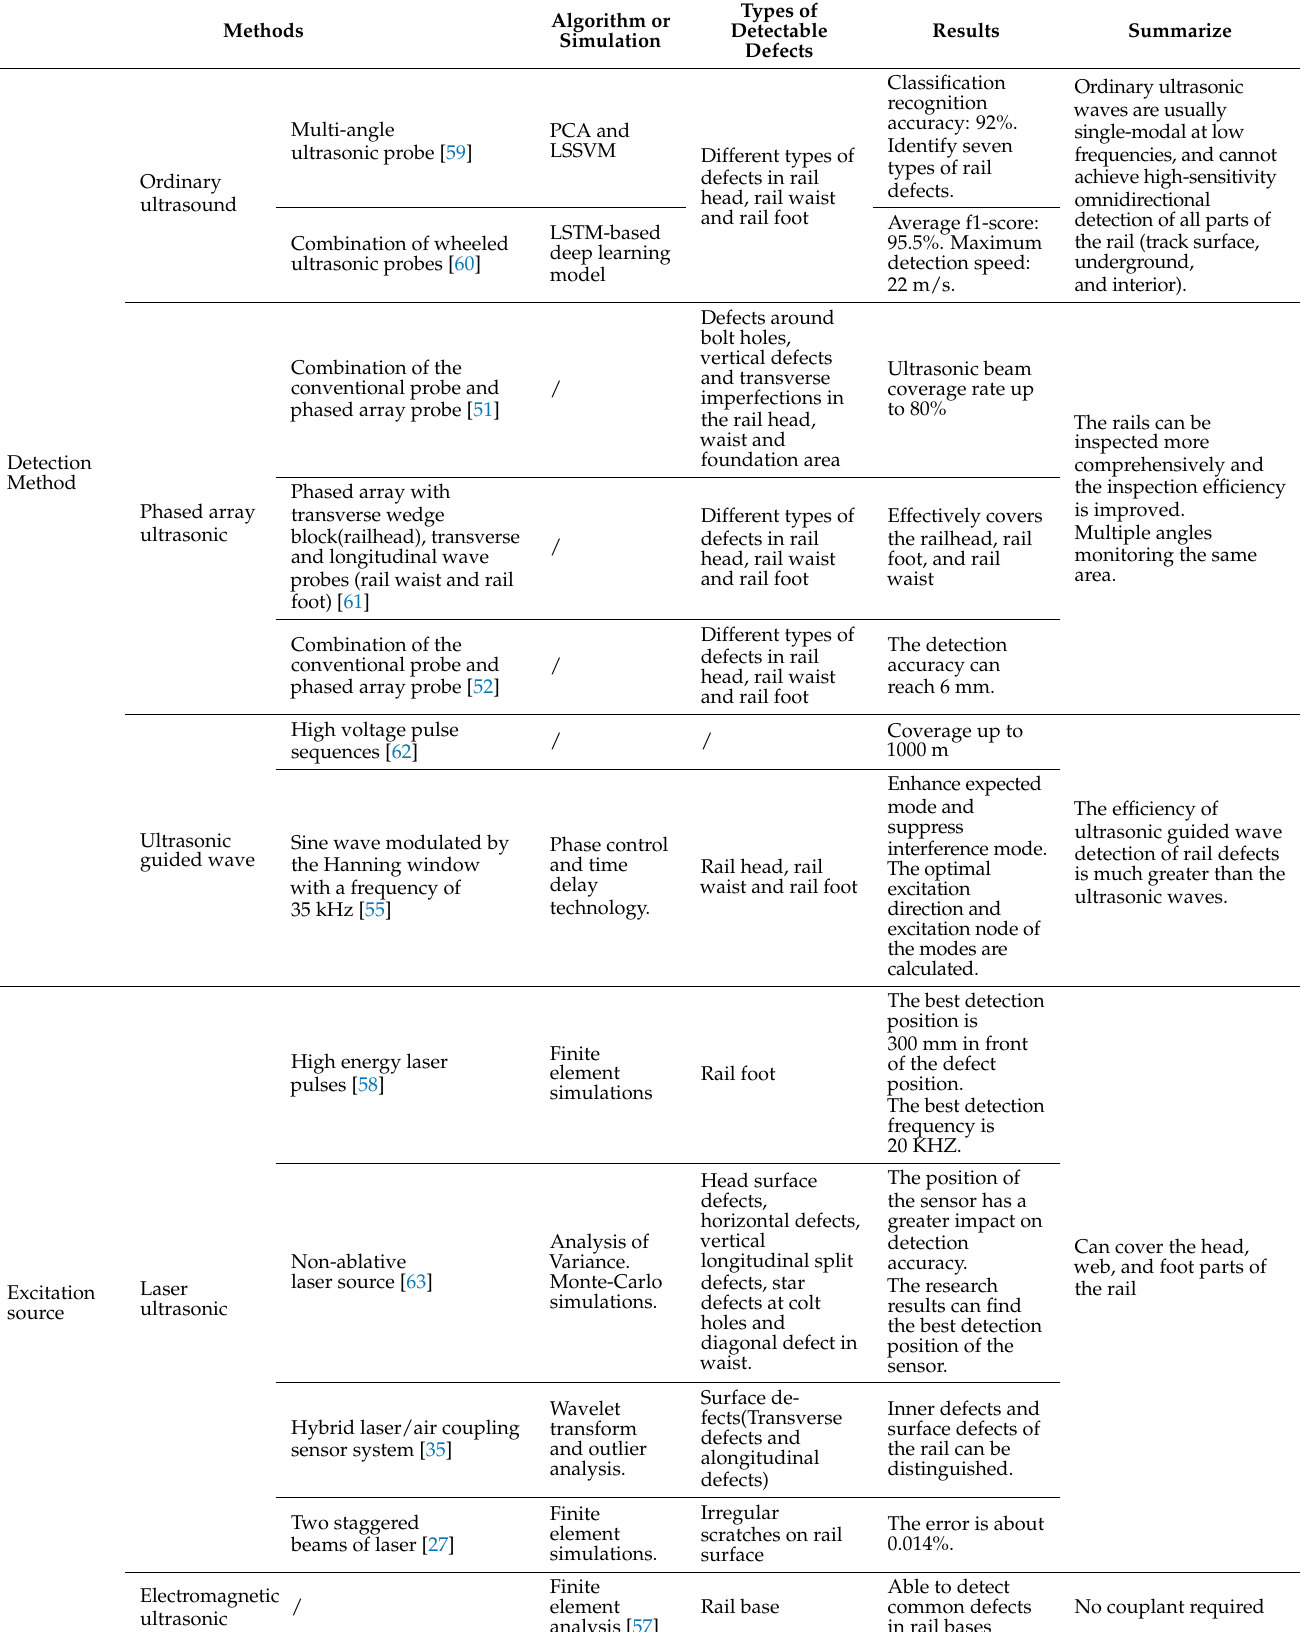
Table 3. Comparison of ultrasonic testing